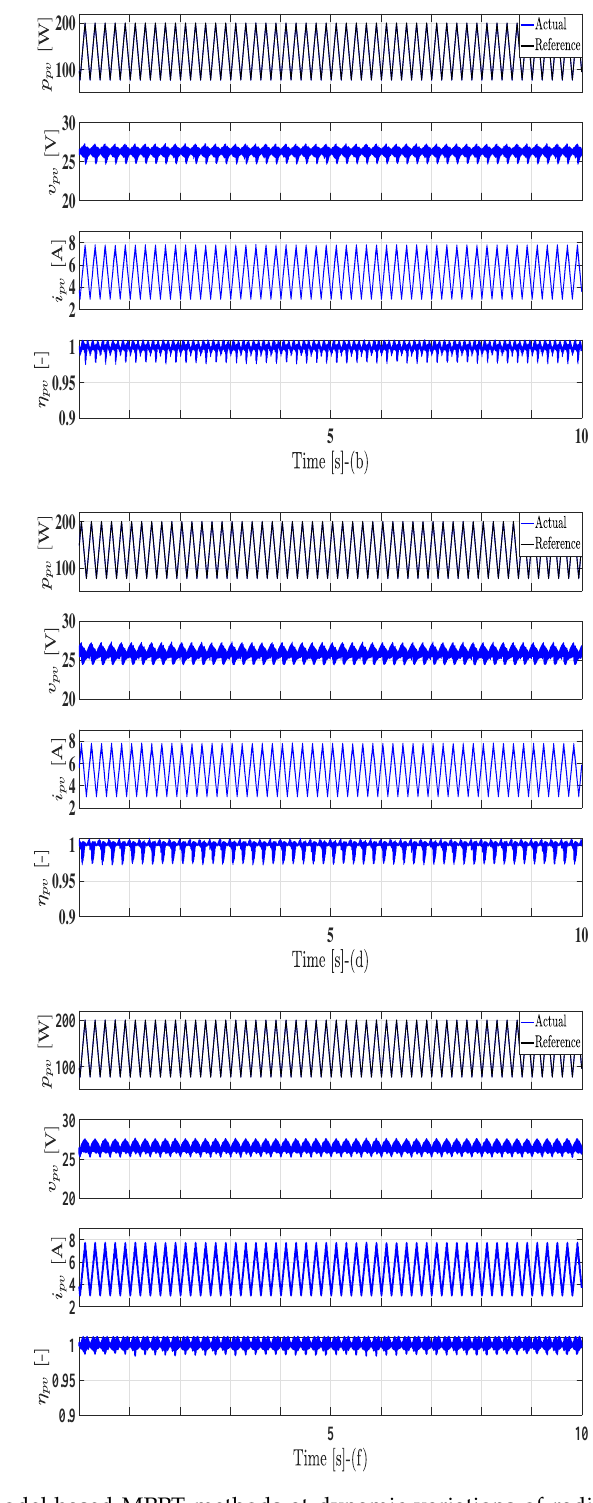
Figure 6. The performance of model-based MPPT methods at dynamic variations of radiation. ( a ) Constant voltage method, ( b ) temperature method, ( c ) voltage-based method (V1), ( d ) voltage- based technique (V2), ( e ) current-based algorithm, ( f ) curve fitting